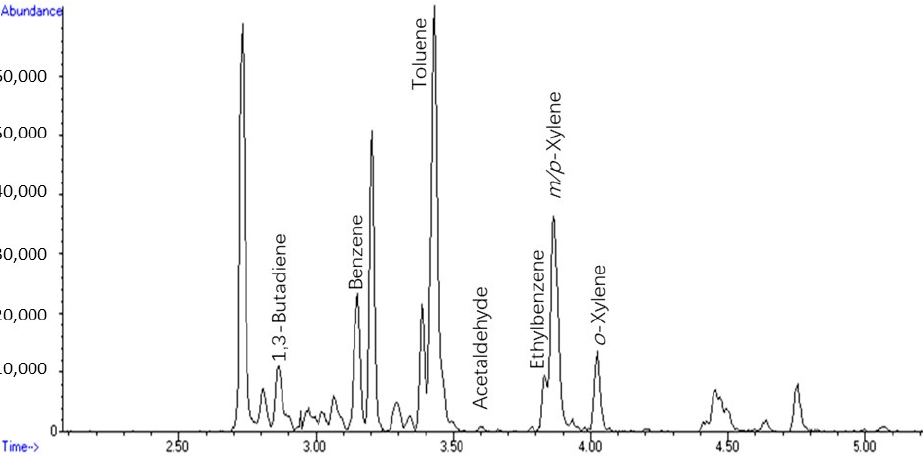
Figure 4. Chromatogram of exhaust gas. Table 9. Retention time for unregulated emissions.